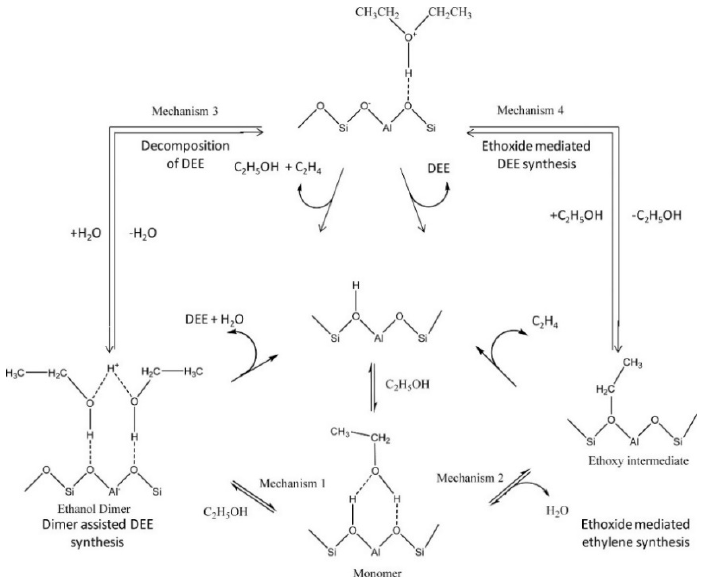
Figure 13. Mechanistic scheme of ethanol dehydration over MFI zeolite. Reprinted with permission from [97]. Copyright 2017 Elsevier B.V.